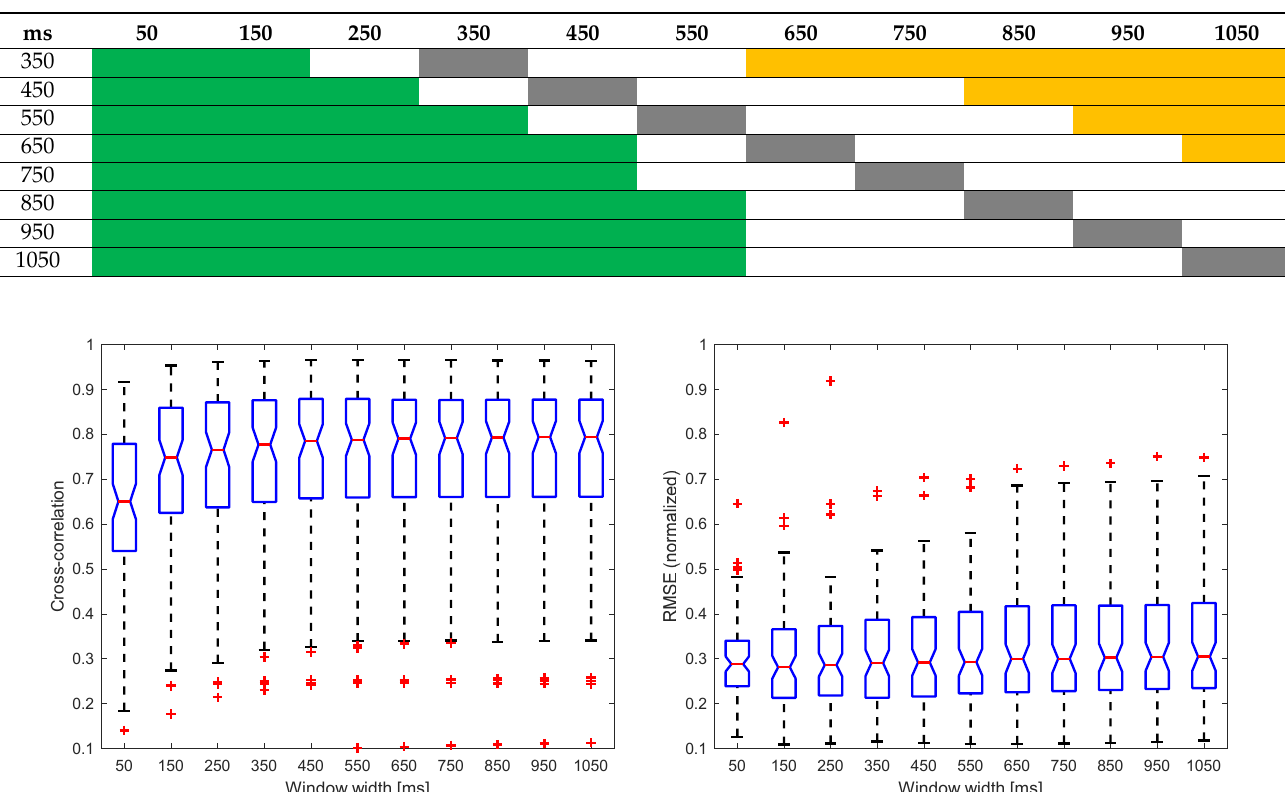
Sensors 2022 , 22 , x FOR PEER REVIEW